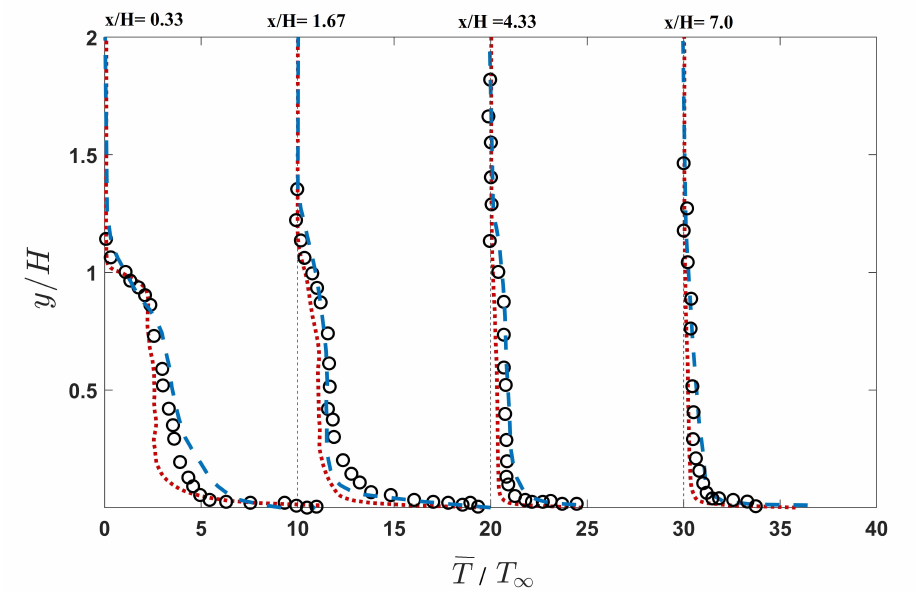
Figure 5. Mean temperature profiles in various streamwise locations. IDDES (red dotted line), LES (blue dashed line), and corresponding experiment